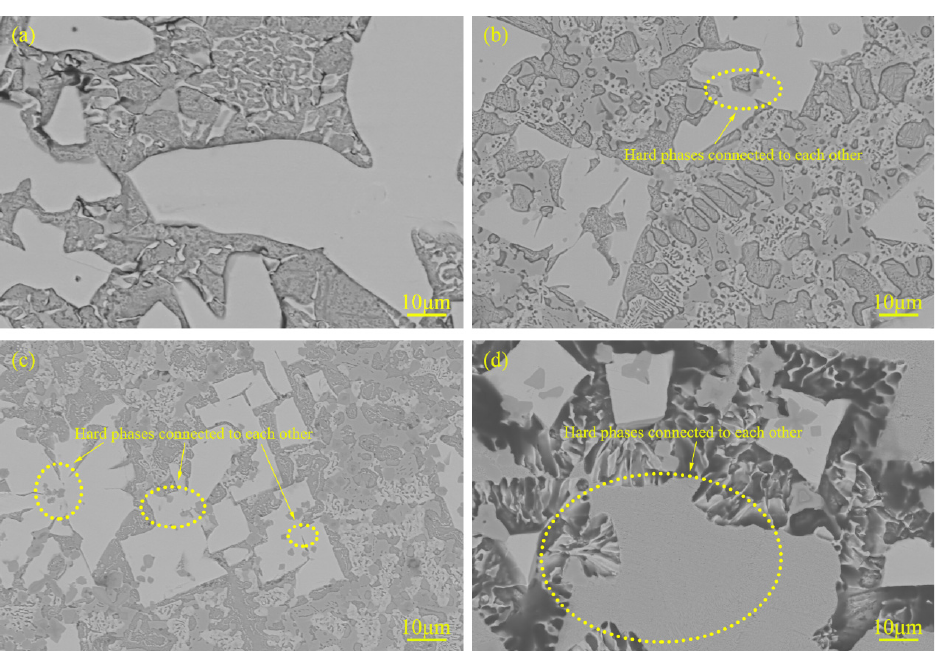
Figure 4. Microstructural morphology of claddings with different TiC contents ( a ) TiC = 0%, ( b ) TiC = 5%, ( c ) TiC = 10% and ( d ) TiC = 15%.